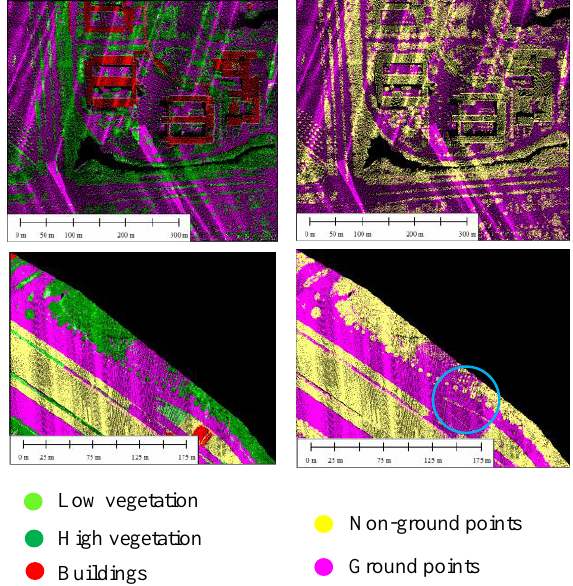
Figure 8. Filtering results from site 1 (top) and 9 (down). The left figures are the original point clouds rendered by classes and the right is the filtering results. (The areas without LiDAR coverage are shown as black in the pictures) The DEM is generated from the ground points as shown in Figure 9. Compared to the other three algorithms, it is obvious that the proposed SATPS method performs better to filter building areas and preserve ground points inside the buildings at the same time , as shown in the red circle of Figure